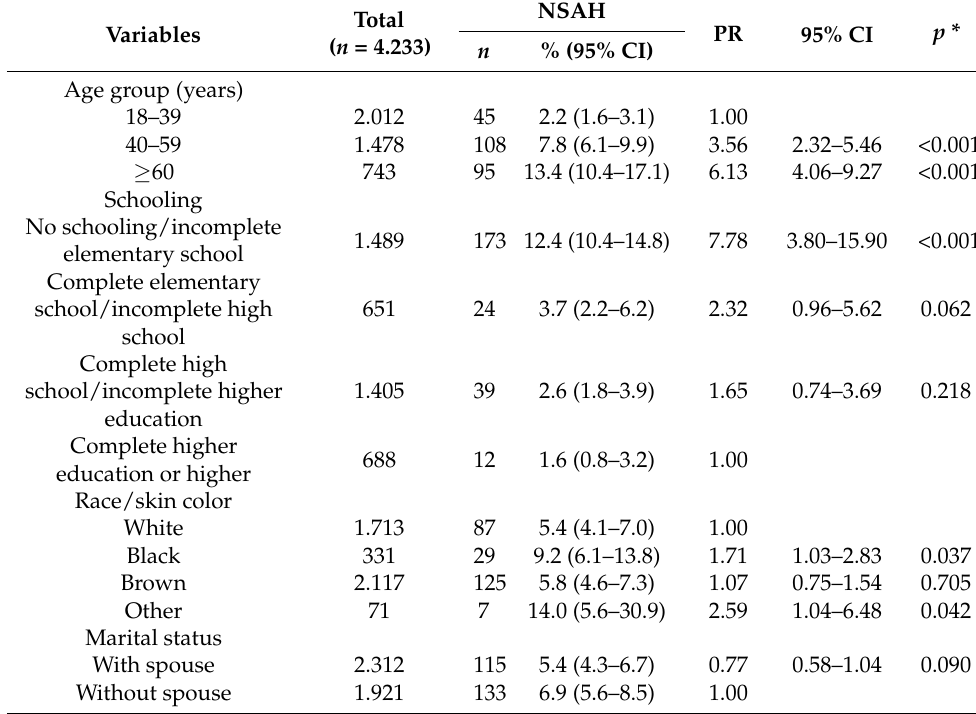
Table 2. Bivariate analysis of factors associated with negative health self-assessment in women. Midwest Region, Brazil, National Health Survey,